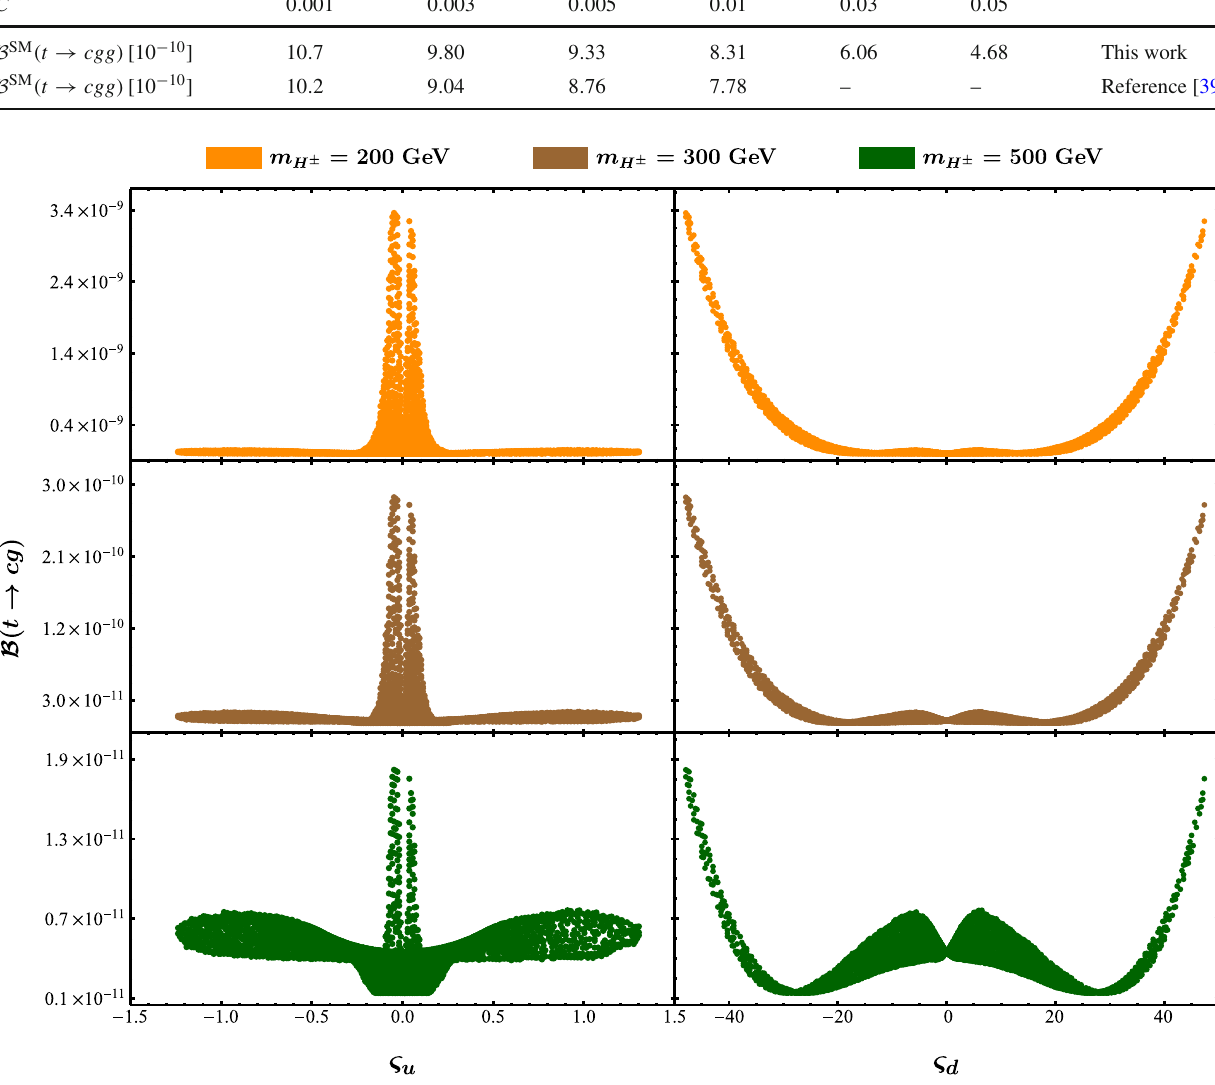
Fig. 3 The branching ratio B ( t → cg ) as a function of the alignment parameters ς u (left) and ς d (right), for three benchmark values of the charged-Higgs mass, m H ± = 200, 300, and 500GeV, represented by the orange (top), brown (middle), and dark green (bottom) scatter plots, respectively. Here we have used the relevant constraints on the align-